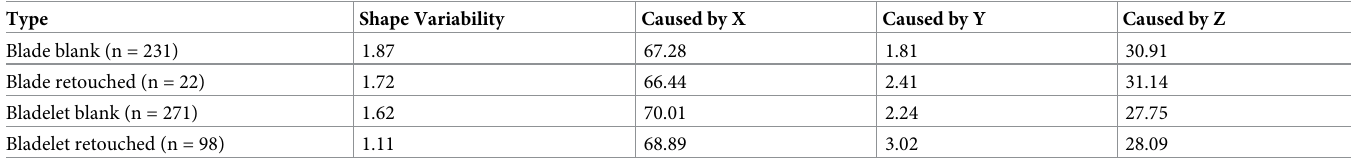
Table 4. Shape variability report across classes and the respective proportion (in %) caused by the three physical dimensions. X represents the width, Y the length, and Z the thickness.